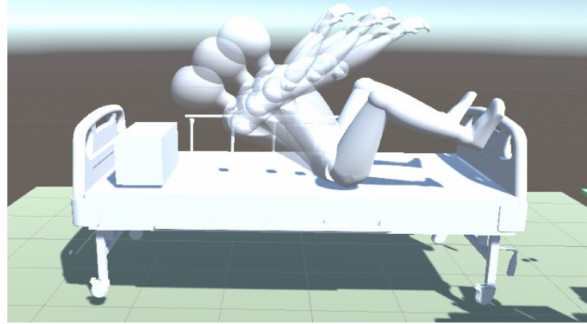
Figure 15. The human posture changing diagram.